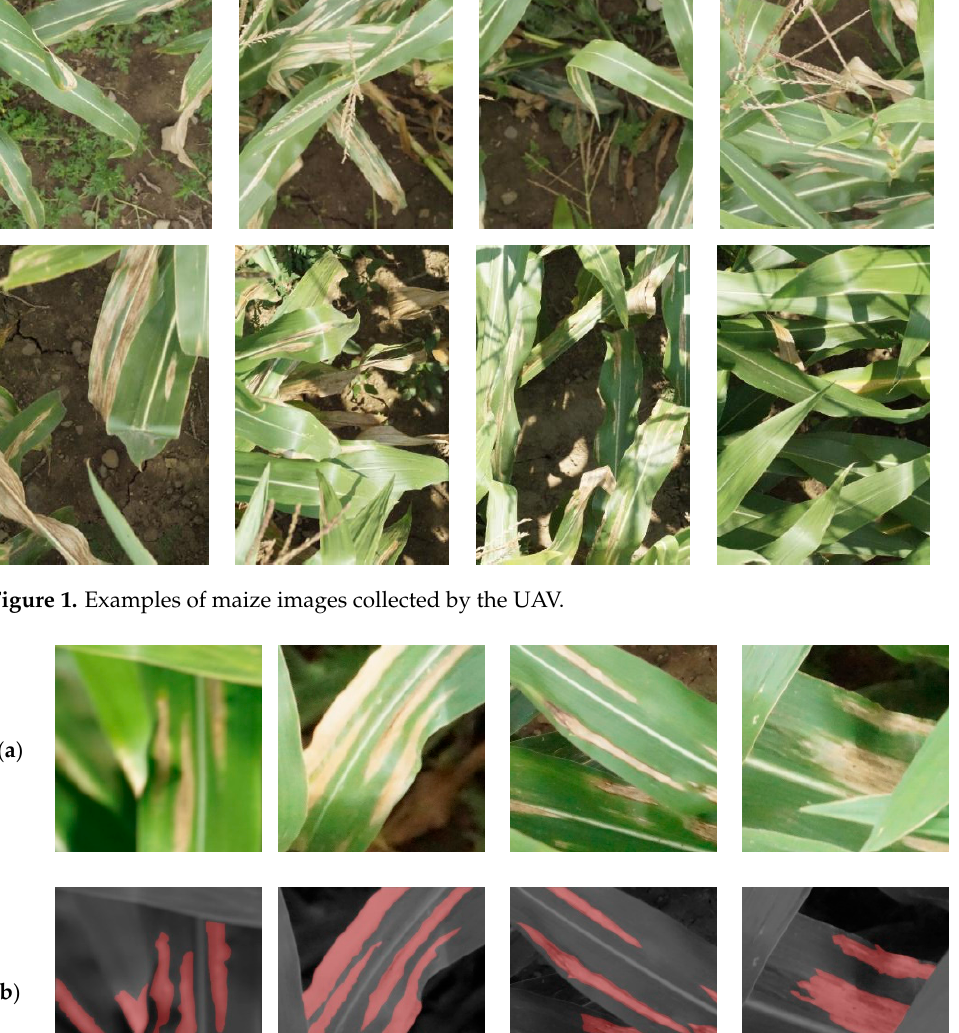
Figure 1. Examples of maize images collected by the UAV .